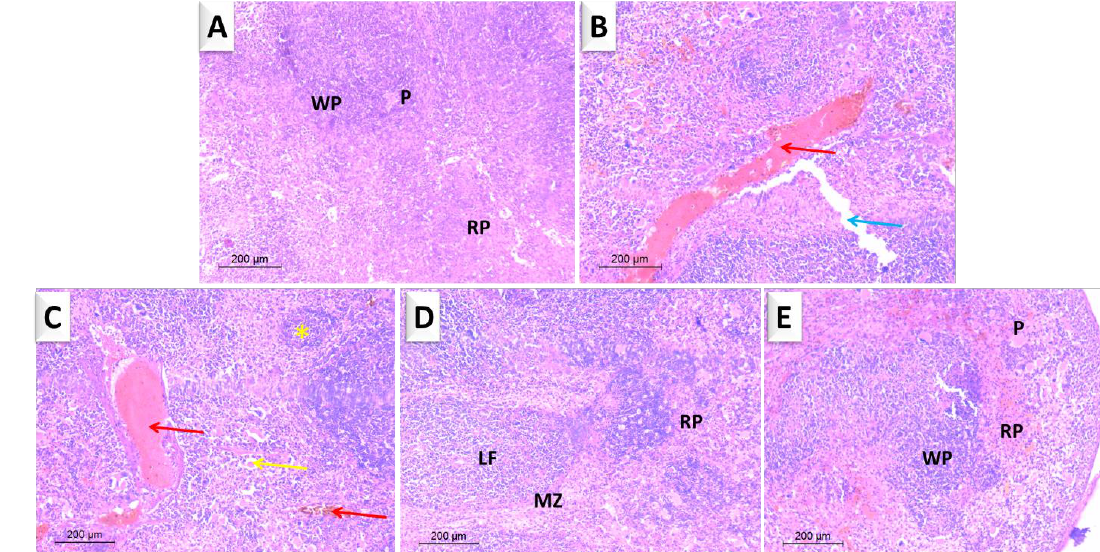
Figure 7. A photomicrograph illustrates several H&E-stained tissue specimens from the cerebral cortex, liver, and spleen. ( A ); Group I healthy control ( B ); Group II infected control ( C ); Group III received Zn-NPs ( D ); Group IV received GO-NPs ( E ): Group V received ZnO-MWCNT. Note: Red arrow refers to blood vessel, Green arrows refer to normal neuron, INF: cerebral infract, S: spongy matrix, H: hemorrhage, Bent black arrow: necrotic neurons, Black arrows: perivascular neurons, Black stars refer to dilated blood sinusoids, Blue arrow: cellular degeneration, RP: red Pulp, WP: white Pulp, LF: Lymphoid follicle, MZ marginal zone, P: periarteriolar lymphocyte sheath, Yellow arrow: cellular vacuole and Yellow star: Small lymphoid follicle.